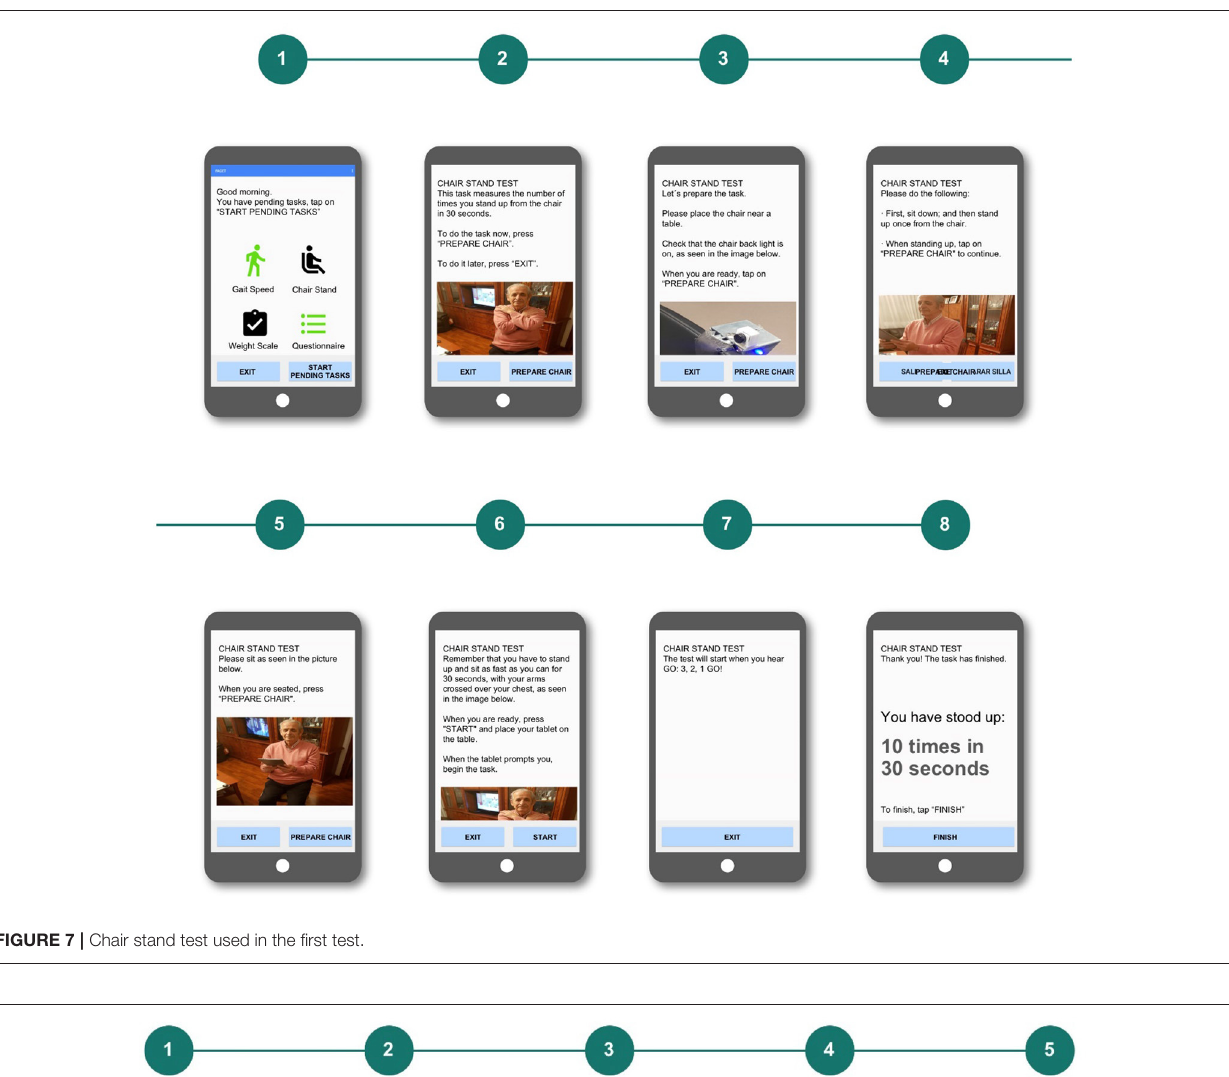
FIGURE 7 | Chair stand test used in the first test.